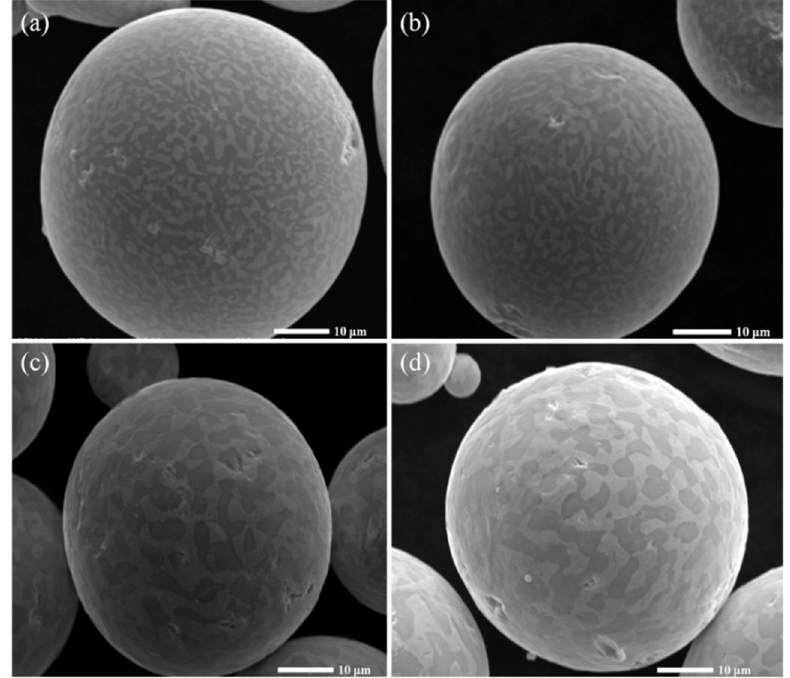
Figure 5. SEM images of rapidly solidified eutectic Sn–Pb37 powder after heat treatment for 1 day in air at ( a ) 40 °C, ( b ) 60 °C, ( c ) 90 °C, and ( d ) 120 °C.